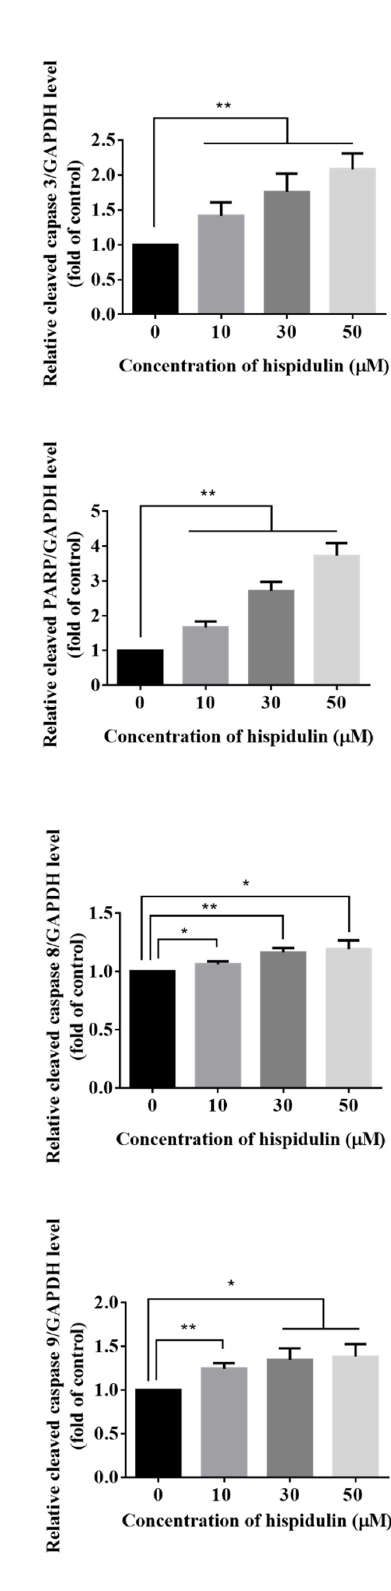
treated with indicated concentrations (0, 10, 30, and 50 µM) of hispidulin for 24 h followed by double-staining with An- nexin V/FITC and PI for flow cytometric analysis to determine the proportion of apoptotic cells. The flow cytometry profile presents Annexin V-FITC ( x -axis) and PI staining ( y -axis). The values represent the percentage of cells in each of the four quadrants (lower left quadrant: viable cells, upper left quadrant: necrotic cells, lower right quadrant: early-stage apoptotic cells, and upper right quadrant: late-stage apoptotic cells). ( B ) The apoptotic cells were quantified with early-stage and late-stage apoptotic cells. Data are presented as percentage of control and mean ± SE, with ** p < 0.01 compared with the control group (n = 6).